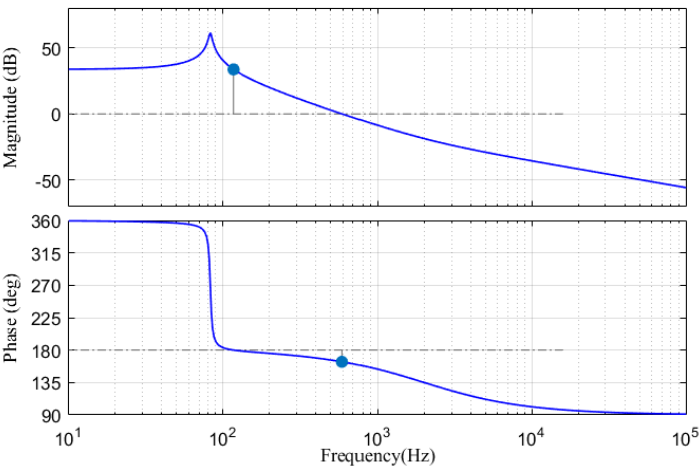
Figure 5. Bode diagram of Gp (s).